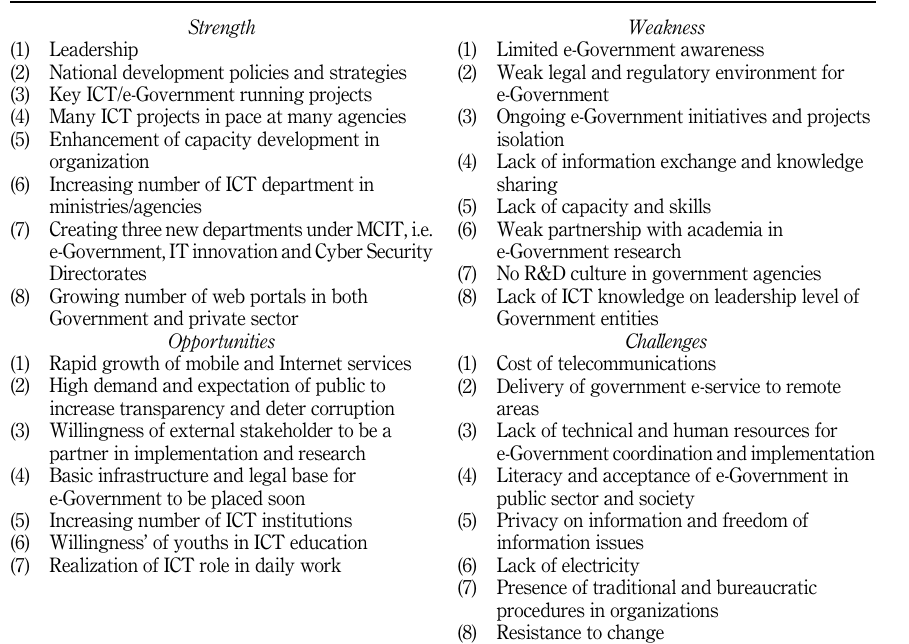
Table 4. SWOC analysis